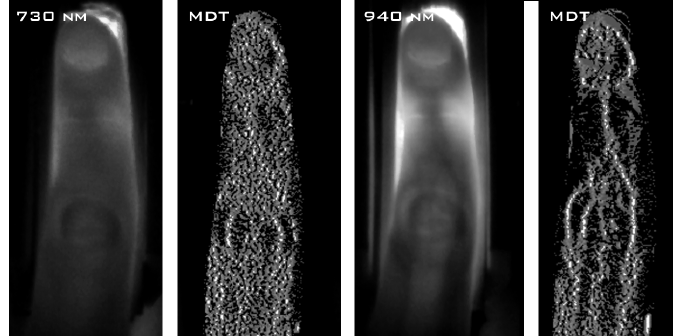
Figure 3. Comparison of MDT processing of images registered at 730 and 940 nm. From the left: original image 1 (730 nm), processed image 1, original image 2 (940 nm) and processed image 2. In both cases the operational window of 9 × 3 pixels was